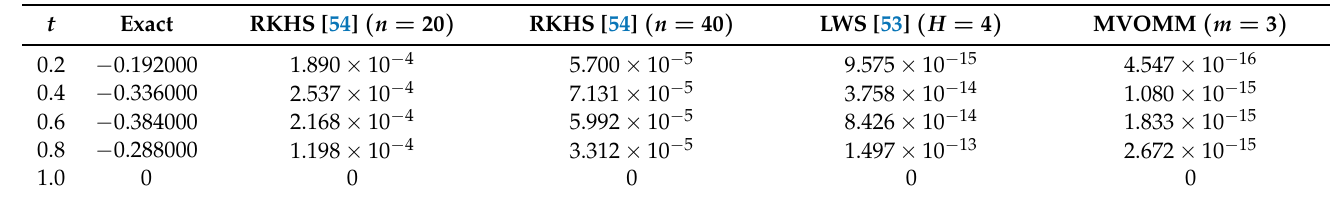
Table 5. Comparison of the present study’s exact solution with the absolute inaccuracy of the RKHS [54] and LWS [53], relative to Example 4.